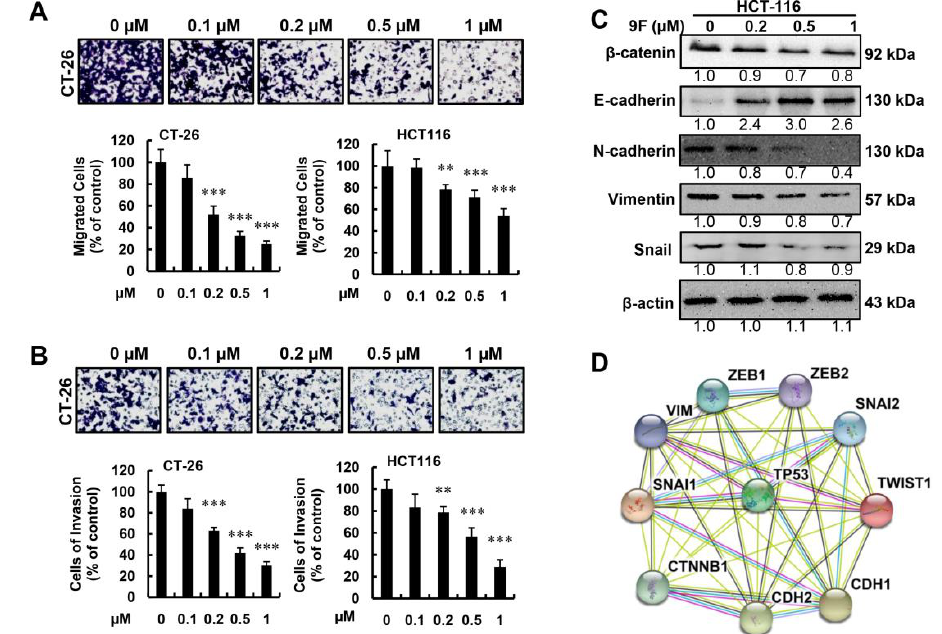
Figure 5. The abilities of migration and invasion were lost in CRC cells exposed to 9F. ( A ) Cell migration of CT-26 cells and HCT116 cells was analyzed by the Boyden chamber assay (20 × ). ** p < 0.01, and *** p < 0.001. ( B ) Cell invasion of CT-26 cells and HCT116 cells was analyzed by the Boyden chamber assay (20 × ). ** p < 0.01, and *** p < 0.001. ( C ) Western blot analyses of epithelial-to-mesenchymal transition (EMT) markers in HCT116 cells following 9F treatment for 48 h. ( D ) PPI network based on STRING showing the detailed interactions of p53 and EMT